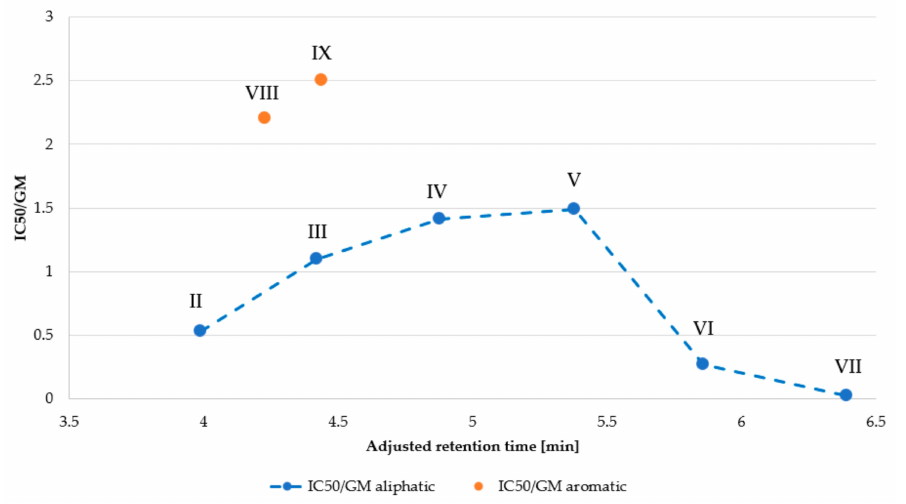
Figure 5. Selectivity for S. aureus over human cells (HaCaT) versus adjusted retention